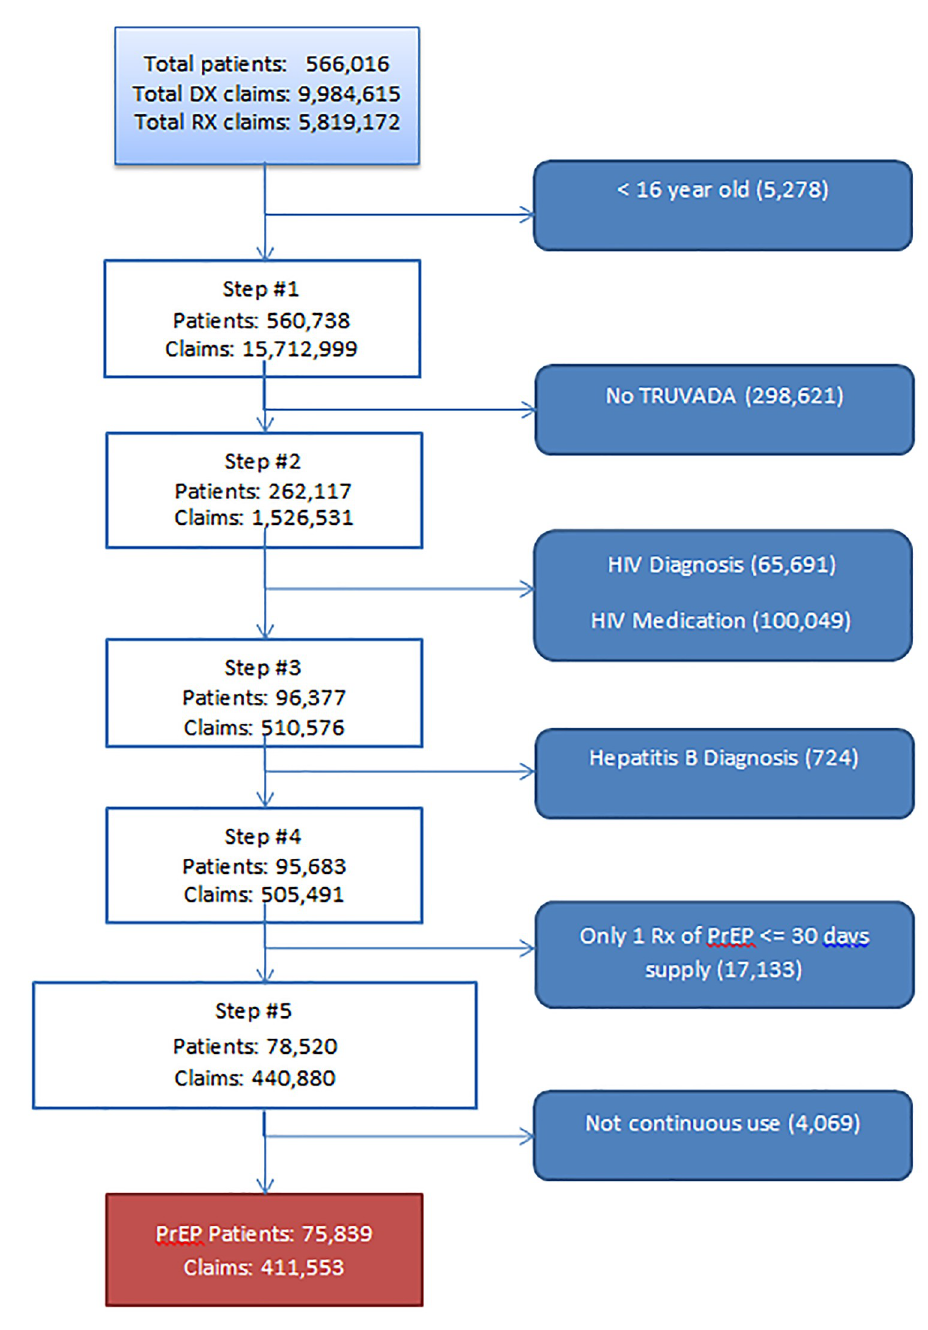
Fig 1. PrEP patient algorithm applied to IDV database, September 2015–August 2016. Dx, diagnosis; IDV, Integrated Dataverse; PrEP, pre-exposure prophylaxis; Rx,